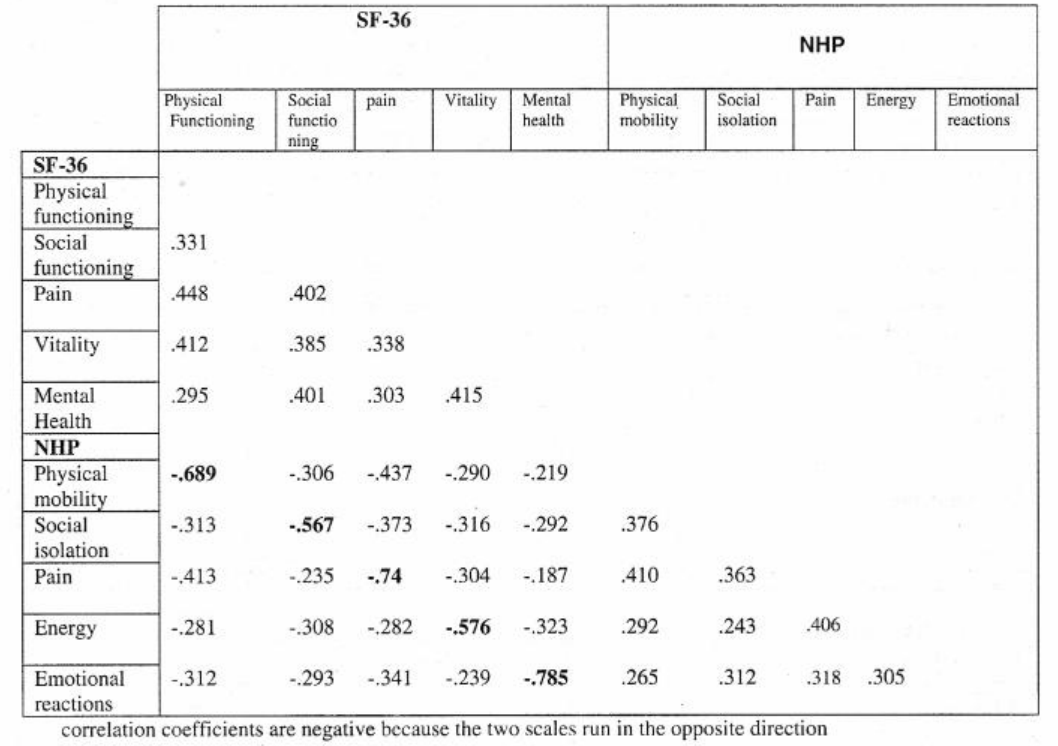
Table 2: MTMMofcorrelation coefficients for SF-36 and NHP for amputee